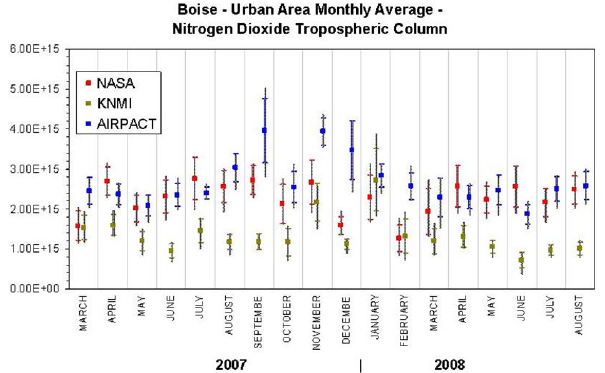
Fig. 7. Monthly Average NO 2 for Boise, Idaho over 18 months. The bars show standard deviation of spatial variation over a 720km 2 area (5 AIRPACT pixels) while the whiskers show the extent of the maximum and minimum. Values are in molecules per square centimeter.